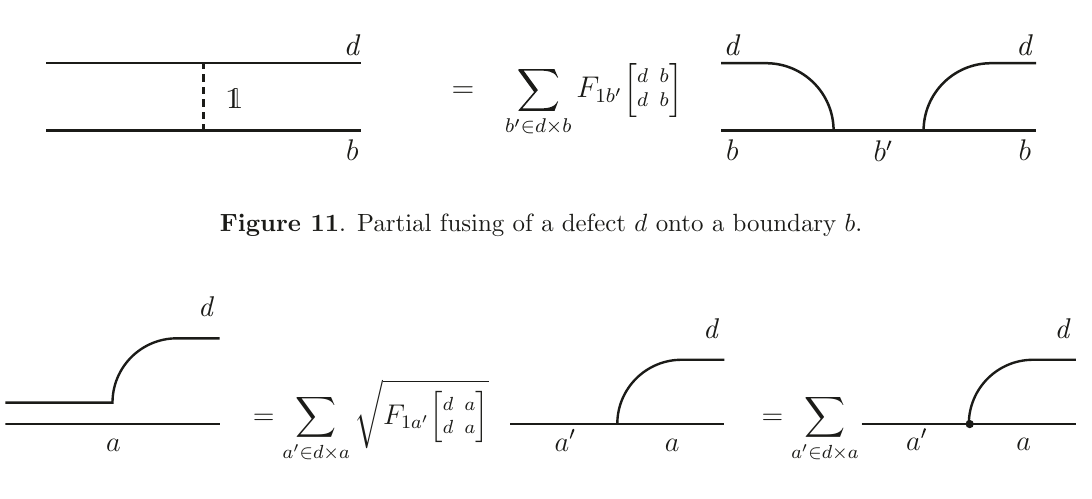
Figure 10 . Defects can be used to derive a relation between the g -functions of different boundary conditions. Defect attached to the boundary can be shrunk in two different directions, producing consistent answer thanks to the identities for the fusion matrix F .